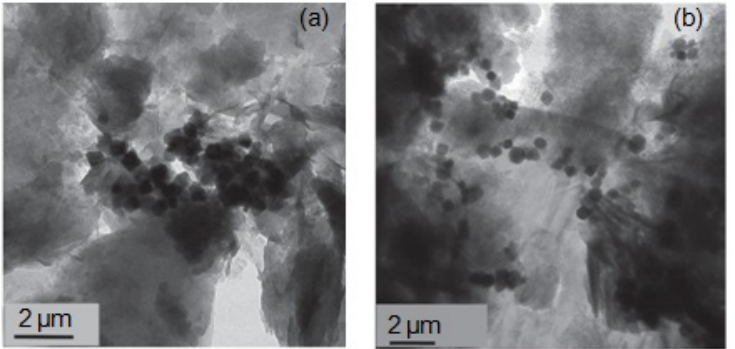
Figure 15. TEM images of ( a ) Fe hybrid materials. Reprinted with permission from [220]. Copyright 2012